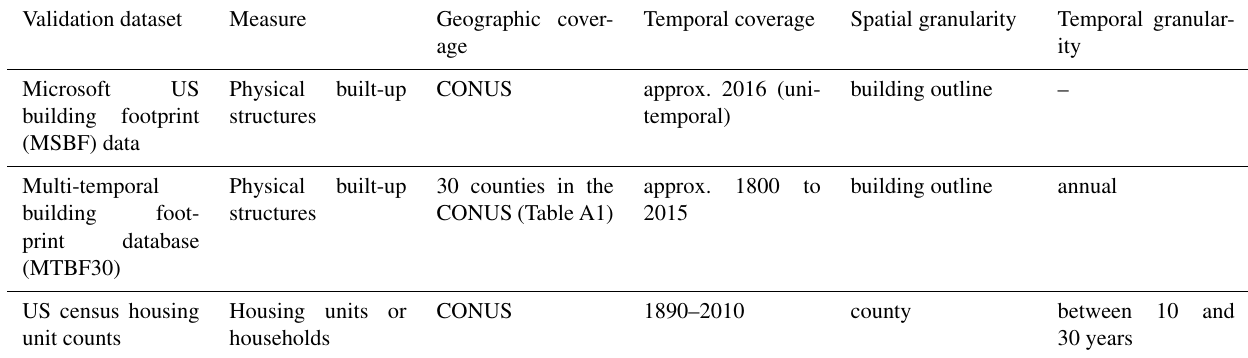
Table 1. Overview of the datasets used for validation of the BUPR, BUPL, and BUA surface series. Validation